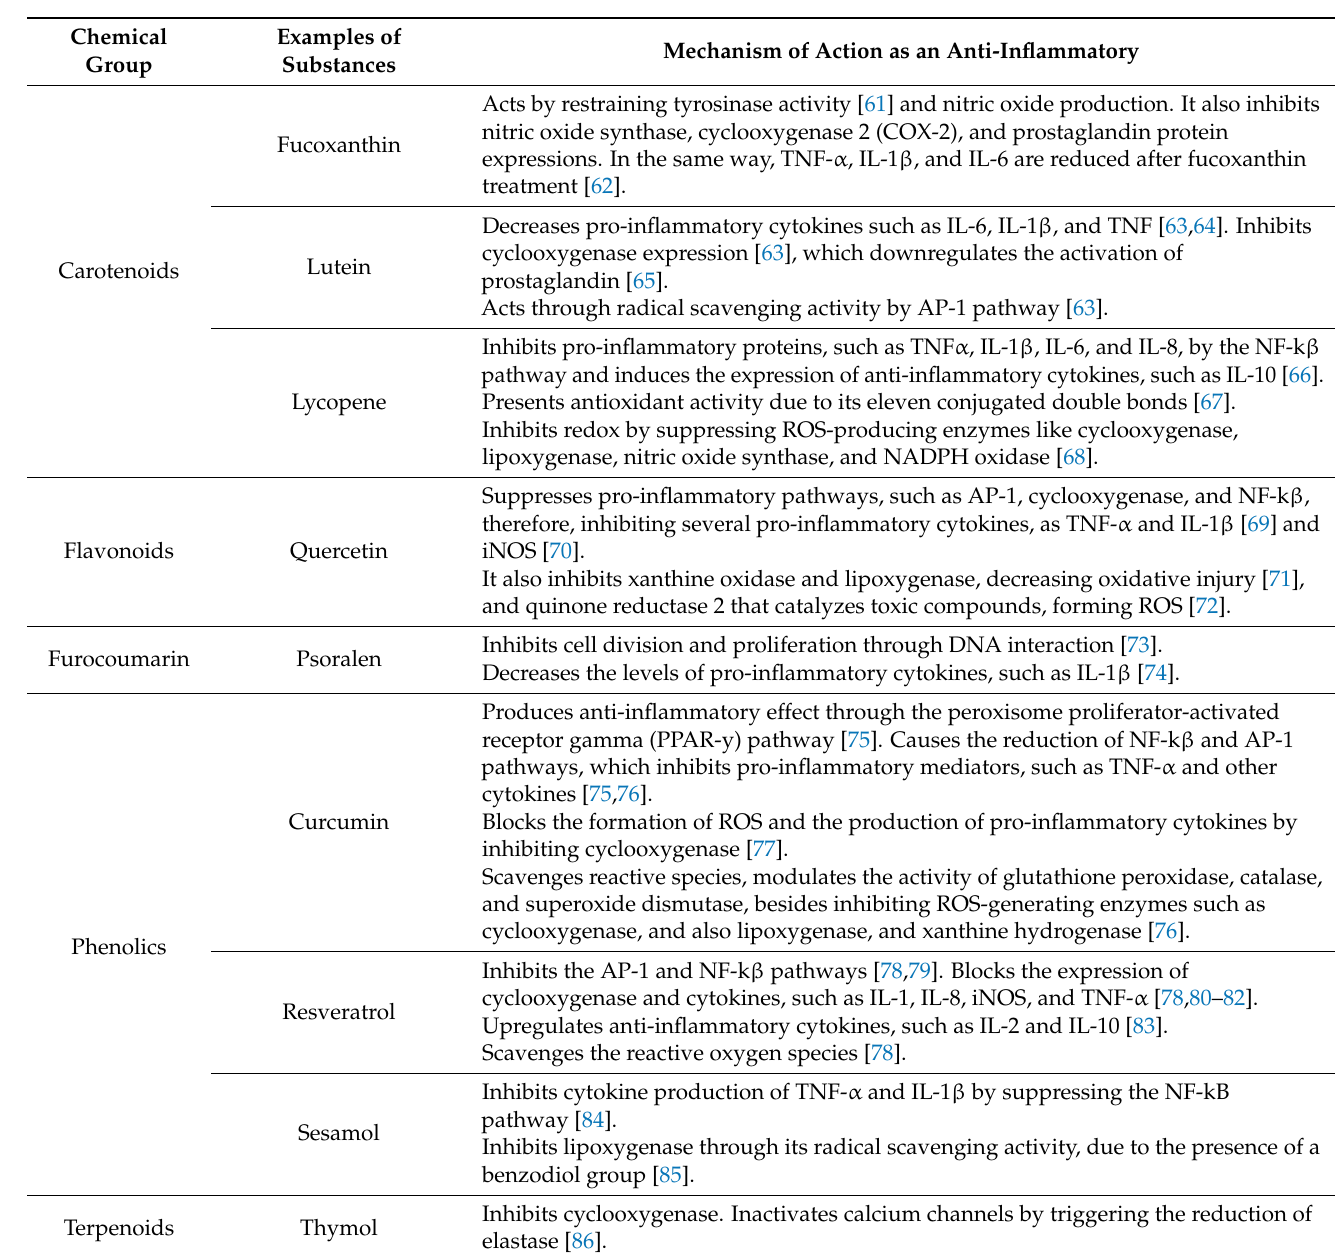
Table 1. Chemical groups and mechanism of action of natural substances extracted from plants that present anti- inflammatory